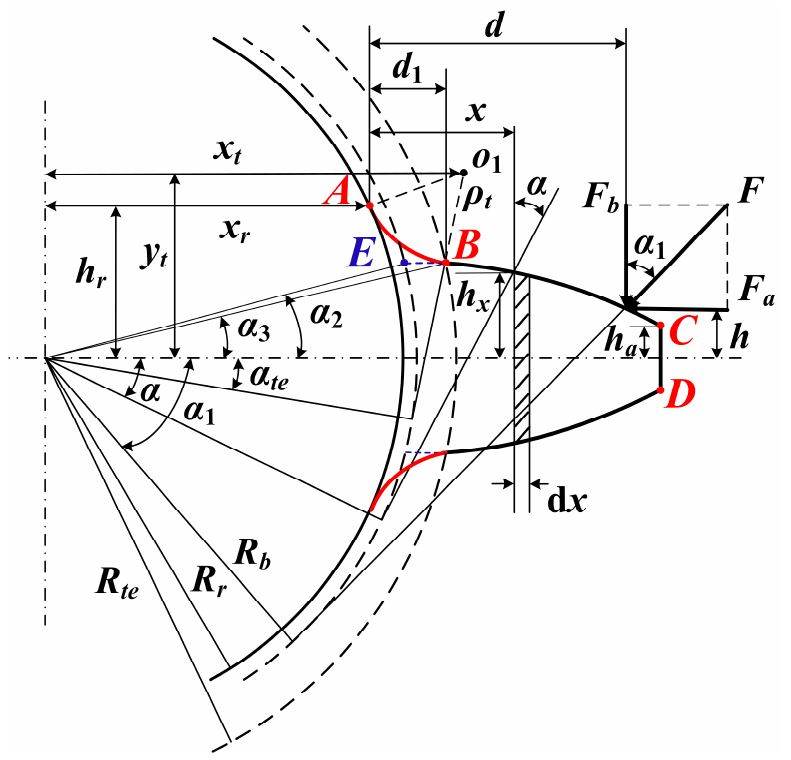
Figure 2. Analytical non-uniform cantilever beam model of a healthy spur gear